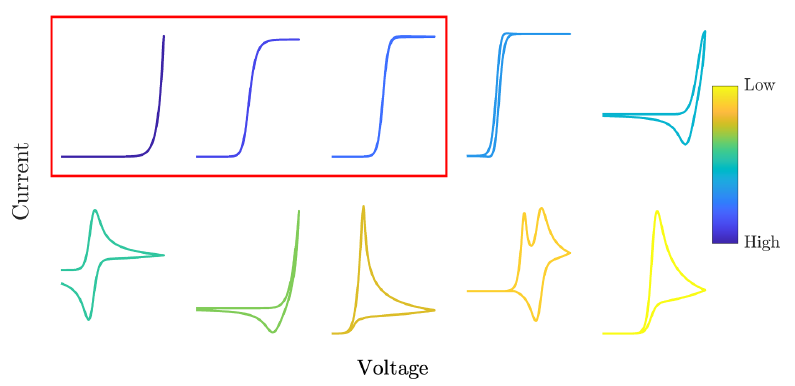
Figure 6. Representative CV curves from the dataset ordered and color coded using the FOWA score. CV curves in the red box will be labeled as targets by the similarity FOWA score based oracle described in this